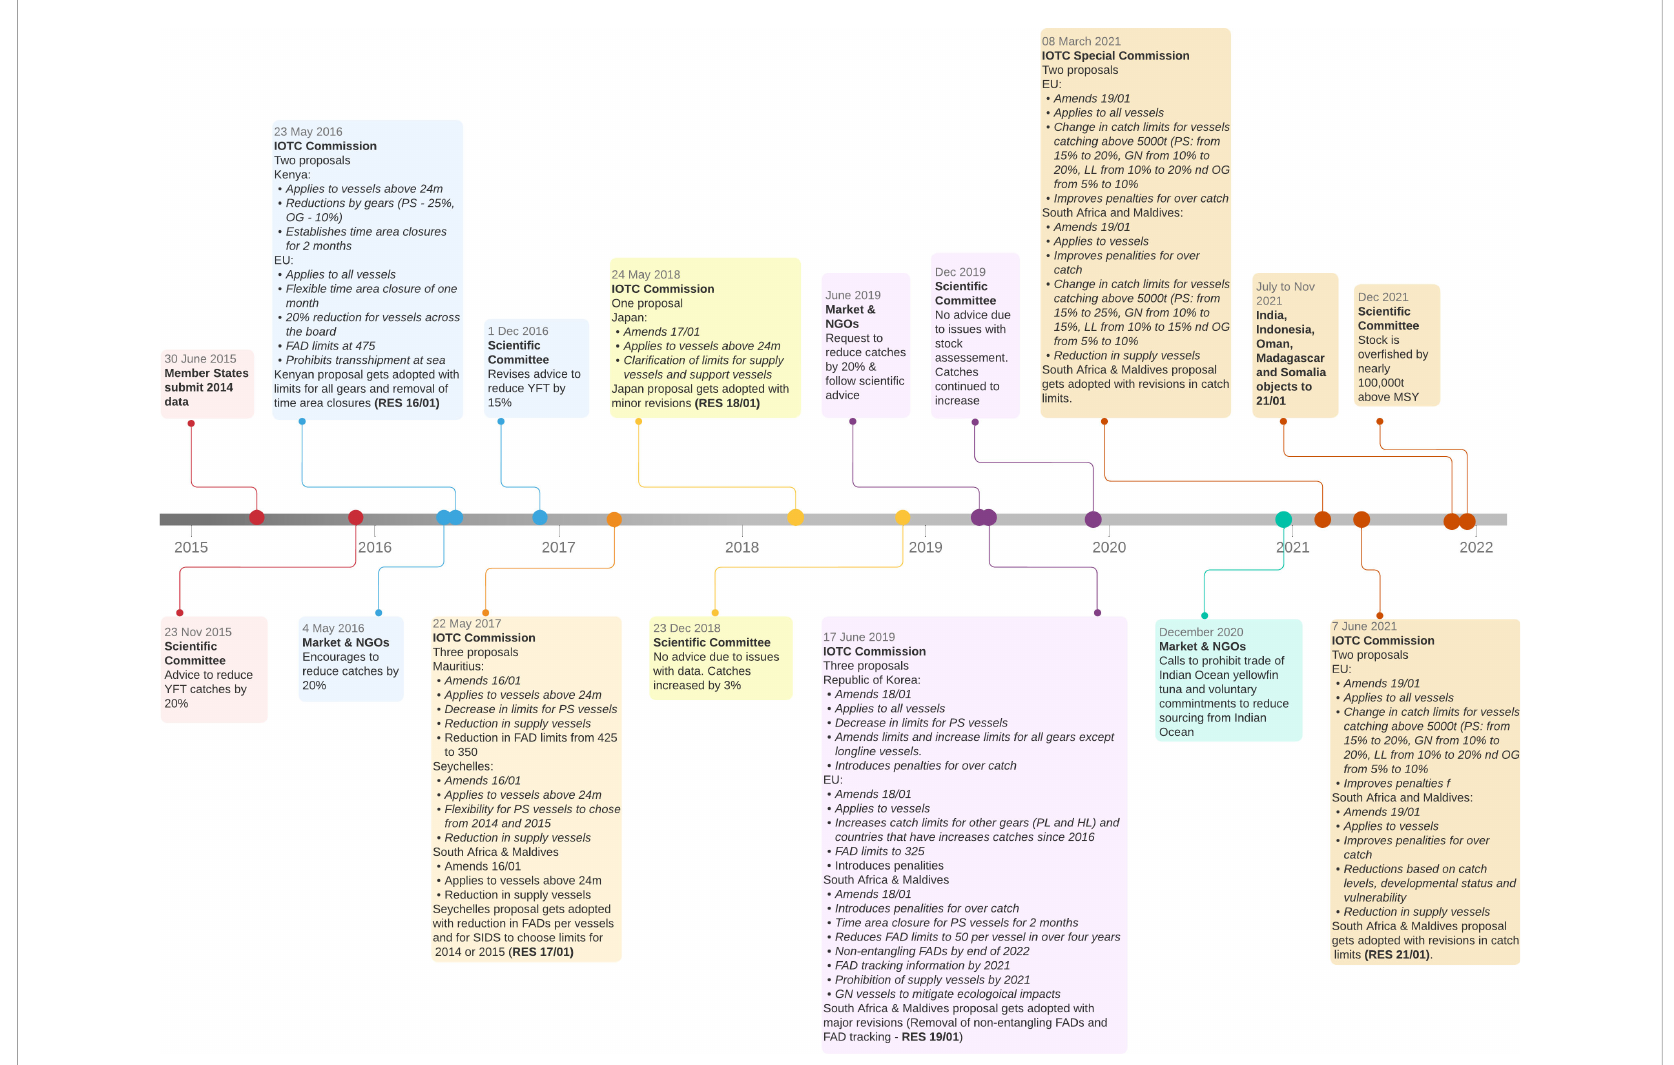
FIGURE 4 Evolution of IOTC scienti fi c advice, NGO involvement and measures adopted to rebuild the yellow fi n tuna stock. The IOTC scienti fi c committee declared the IOTC yellow fi n tuna was over fi shed in 2015 and the stock continues to be over fi shed seven years later. The information was sourced from the IOTC scienti fi c reports, IOTC Commission reports and letters submitted by NGOs and industry during this